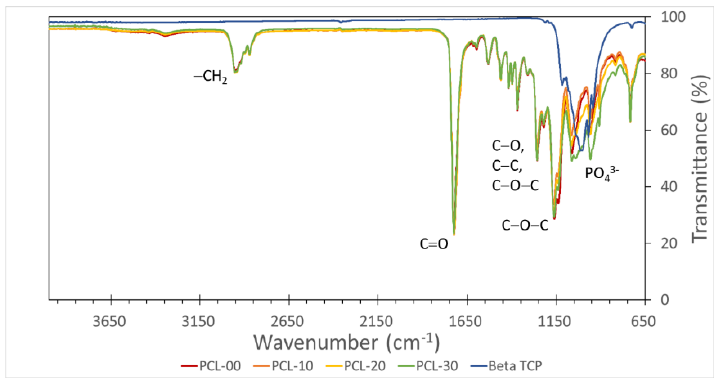
Figure 3. Functional group analysis of PCL/ β -TCP using FTIR. PCL, β -TCP, and different ratios of PCL/ β -TCP were analyzed to determine their functional groups.